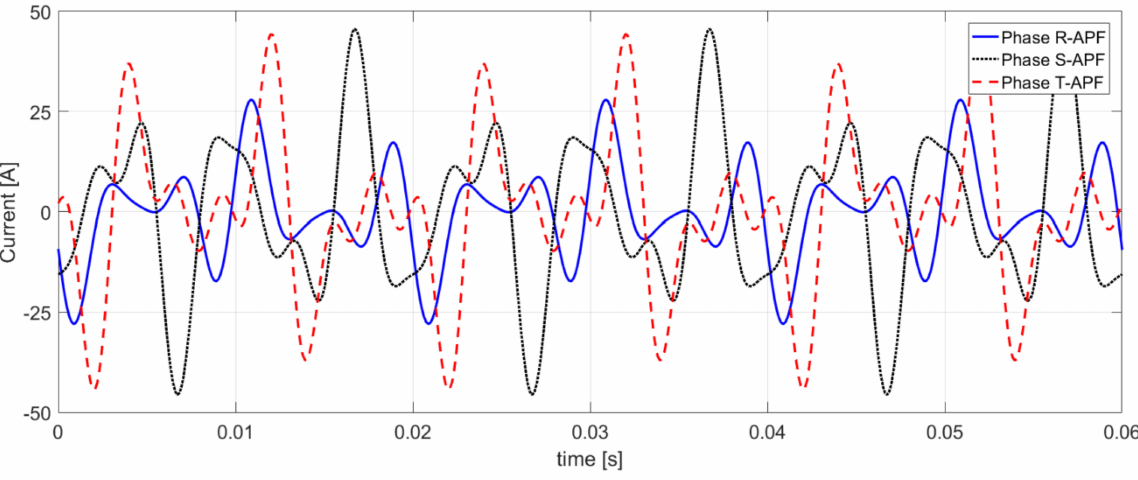
Figure 12. The waveform of three-phase referent current in cross-section X-X’—Equation (42). Based on the reference current generated in this way (Figure 12) and the relation (46) in the Z-Z’ cross-section, a sinusoidal active current waveform is obtained (Figure 13).